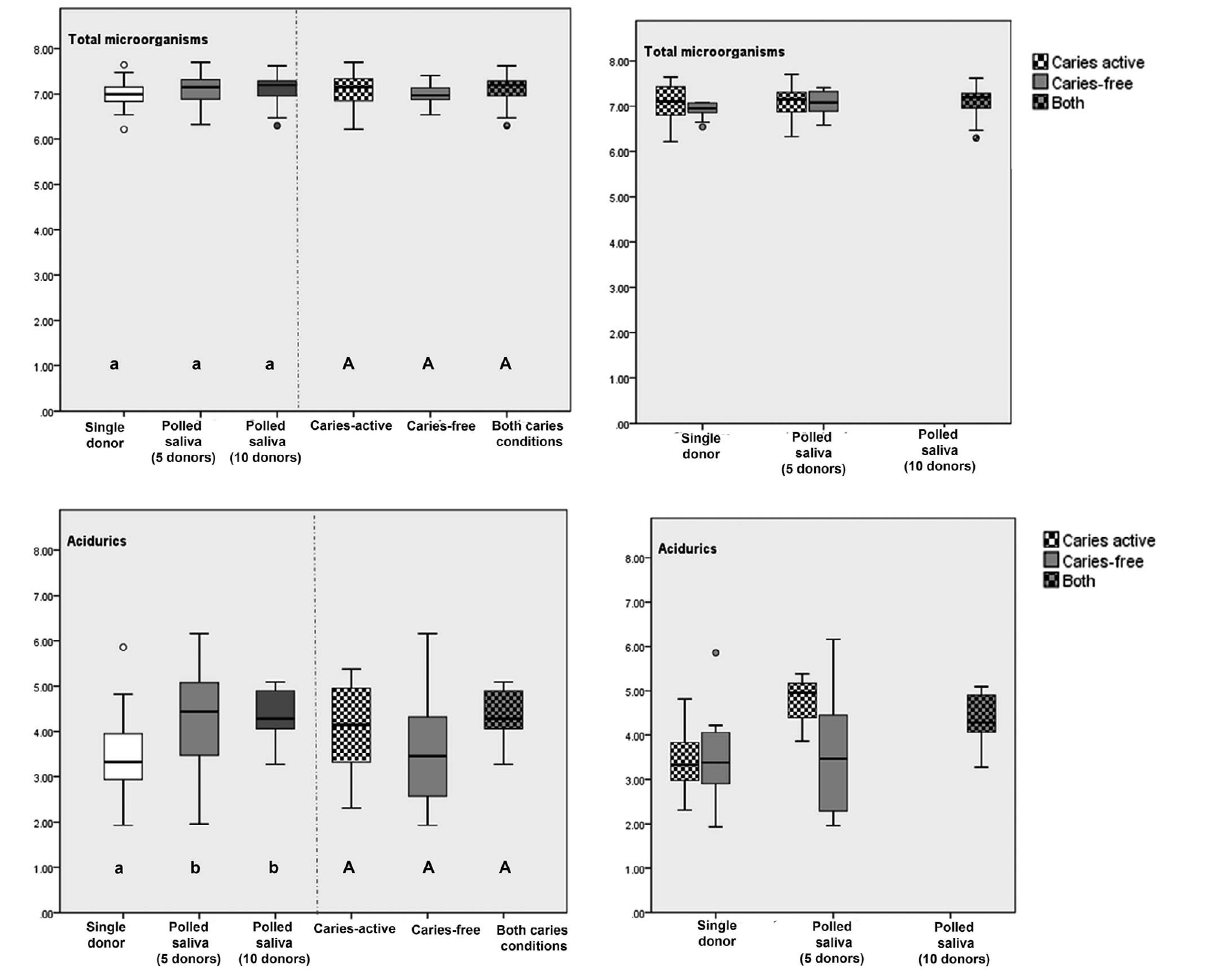
Figure 4- Total microorganisms and acidurics counts (CFU log mg -1 ) and (SD) according to caries activity and inoculum levels (right side) and statistical set-up (left side). Upper case letters show statistical difference between caries activity (caries free, caries active or both). Lower case letters show statistical difference among inoculum level (single donor, pooled saliva from 5 donors and 10 donors). The circles represent outliers and the asterisks extreme